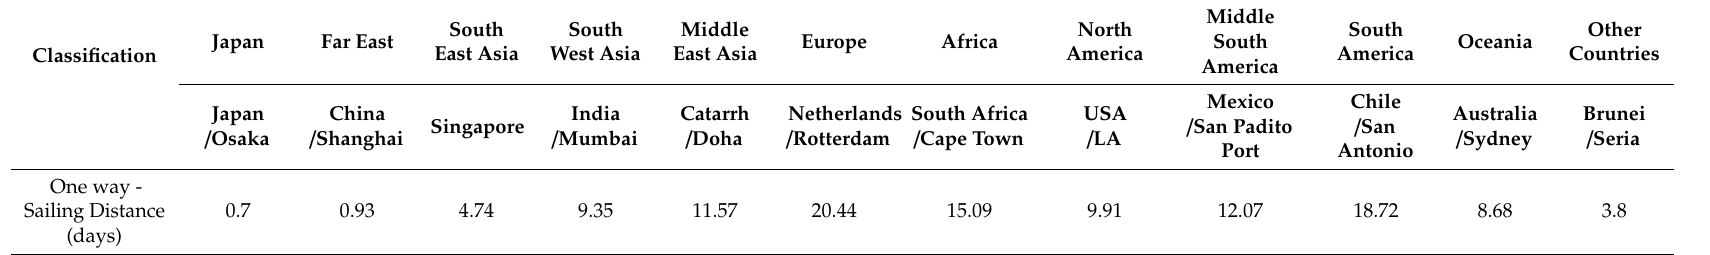
Table A1. Sailing Distance from Busan Port Origin (Container Ship Based).